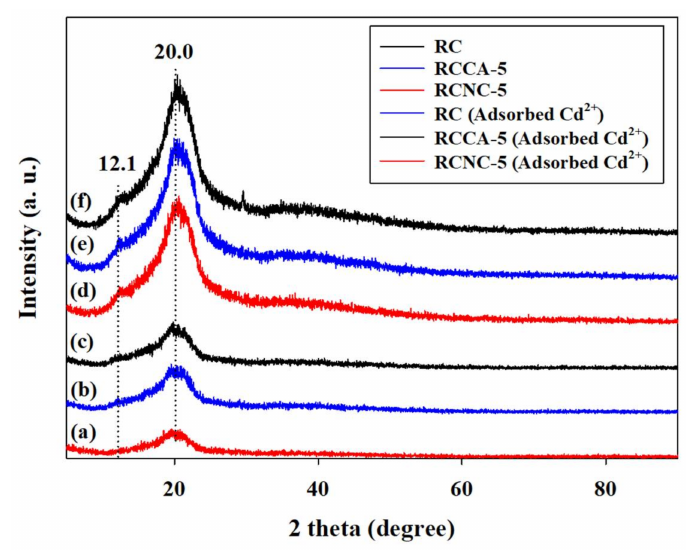
Figure 10. X-ray diffraction patterns of composites (RC, RCCA-5, and RCNC-5) before and after Cd 2+ adsorption: ( a ) RCNC-5 (Adsorbed Cd 2+ ), ( b ) RCCA-5 (Adsorbed Cd 2+ ), ( c ) RC (Adsorbed Cd 2+ ), ( d ) RCNC-5, ( e ) RCCA-5, and ( f )